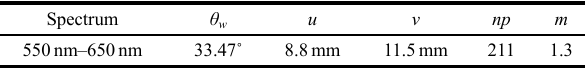
Table 1 Design parameter for spectrum to capture the 1st order spectrum for spectral analysis.